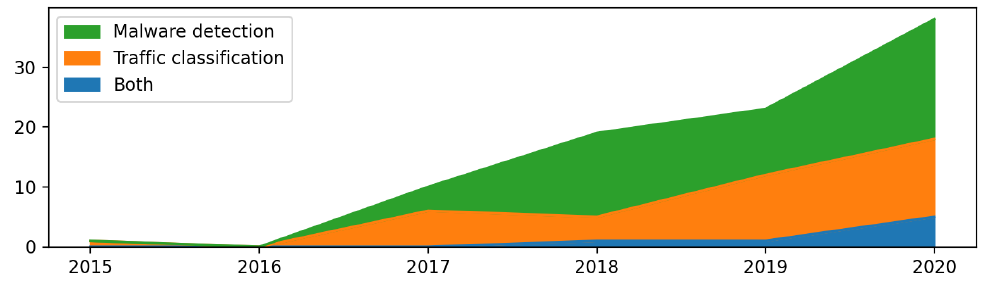
Figure 1. The growth of CNN-based models, which process transformed network traffic in the years